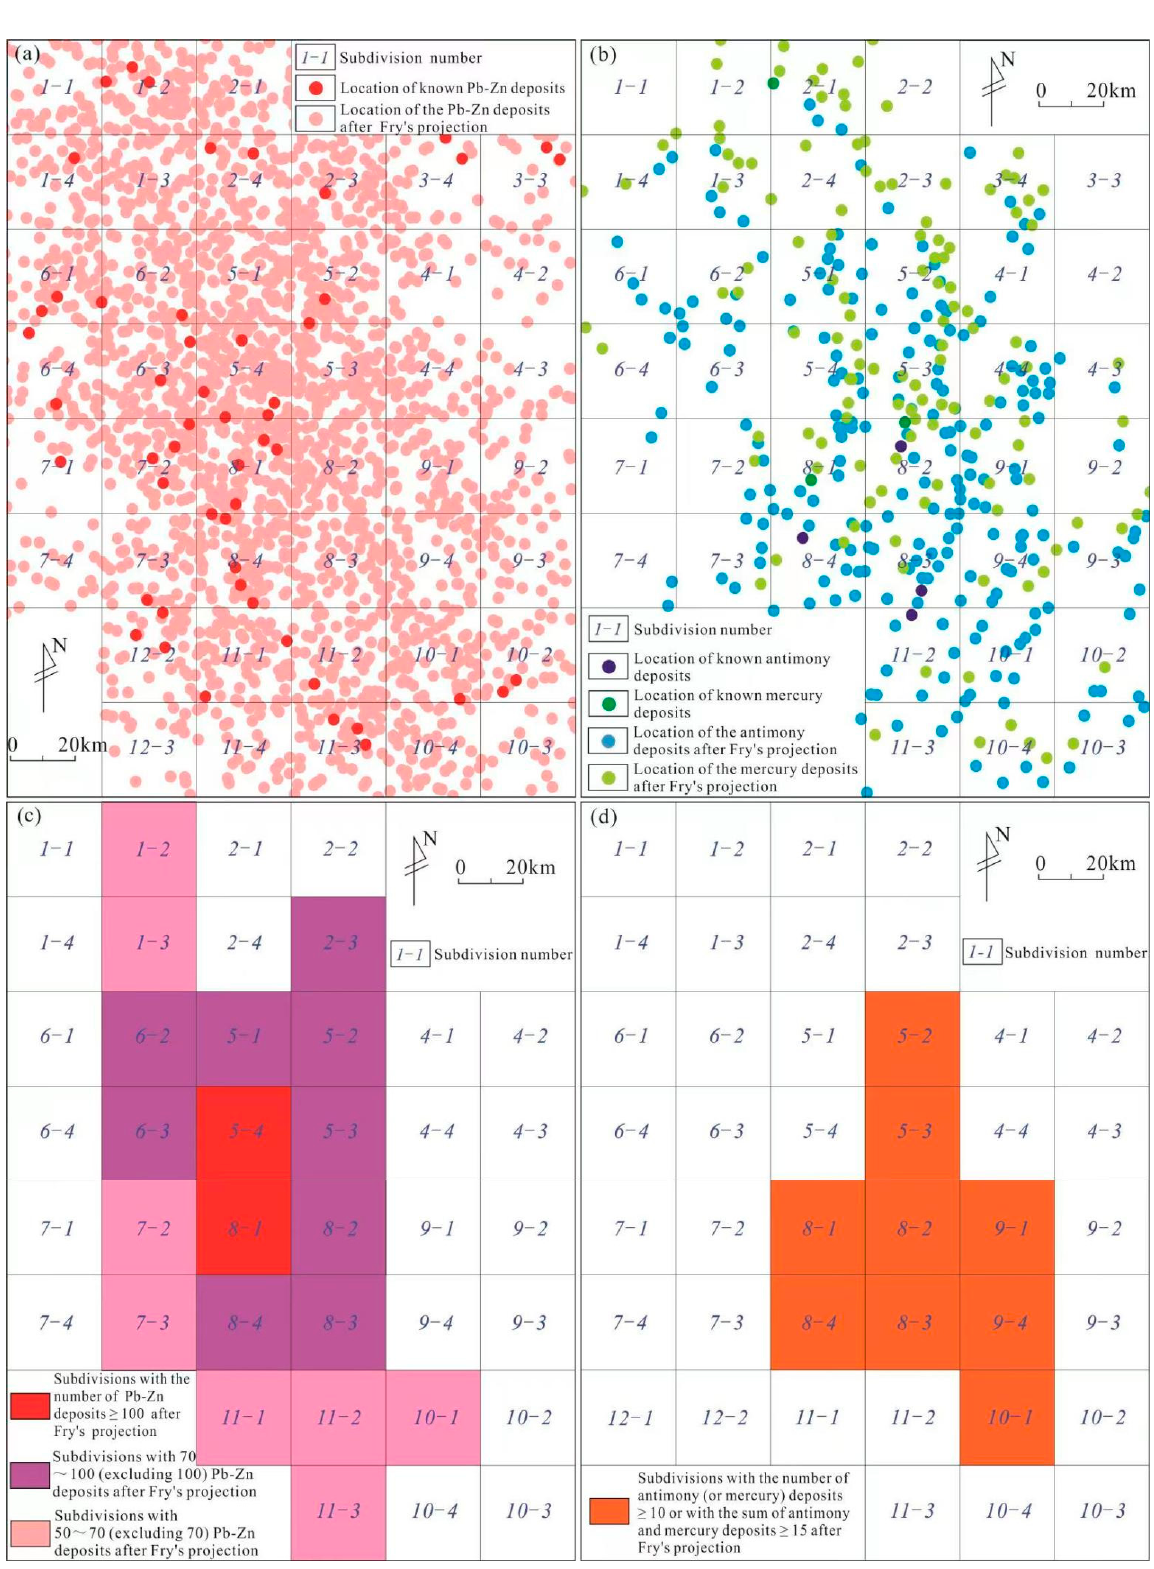
Figure 13. Fry analysis map of the deposit. ( a ) Fry analysis diagram of Pb–Zn deposits; ( b ) Fry analysis diagram of Sb–Hg deposits; ( c ) Fry point distribution map of Pb–Zn deposits; and ( d ) Fry point distribution map of Sb–Hg